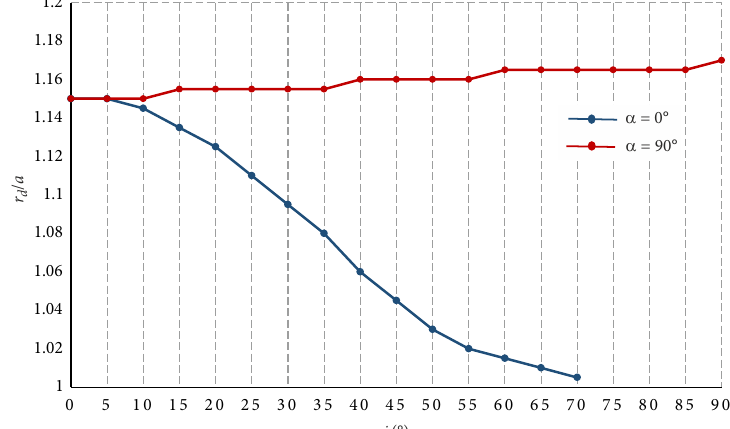
Figure 7. Normalized failure depth versus orientation angle for the strike-slip faulting stress regime